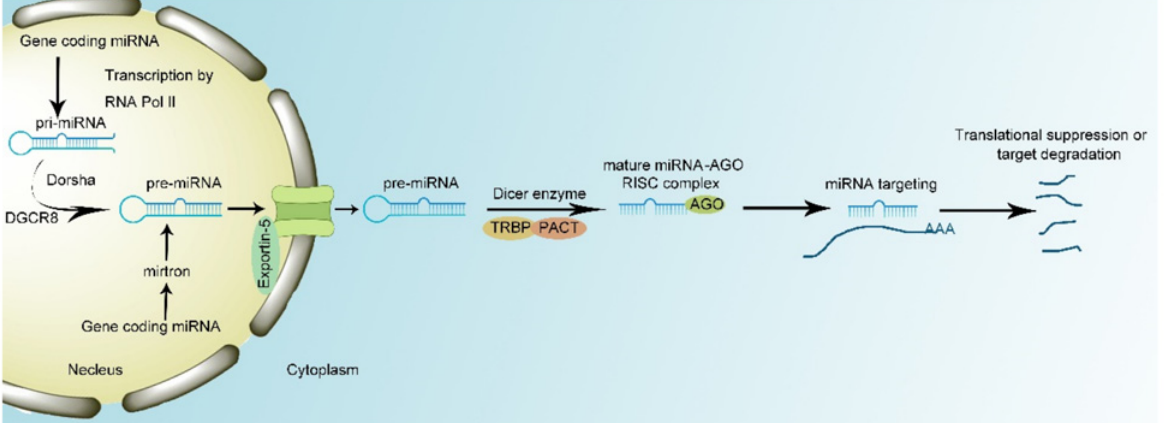
Figure 1. miRNA biogenesis and mechanism of action. miRNA production remains conserved across species. RNA polymerase II transcribes pri-miRNA from genome sequence. Drosha and its cofactor protein bind to primary miRNAs (pri-miRNA) leading to the excision of the loop structure to generate precursor miRNA (pre-miRNA). Then Exportin-5 transports pre-miRNA from nucleus to cytosol. Dicer complex, composed of TAR RNA-binding protein (TRBP) and protein activator of the interferon-induced protein kinase (PACT), manipulates maturation of miRNA and formation of RNA-induced silencing complex (RISC) complex. Mature RISC complex binds to target mRNA with complementary sites, resulting in the translational suppression or target